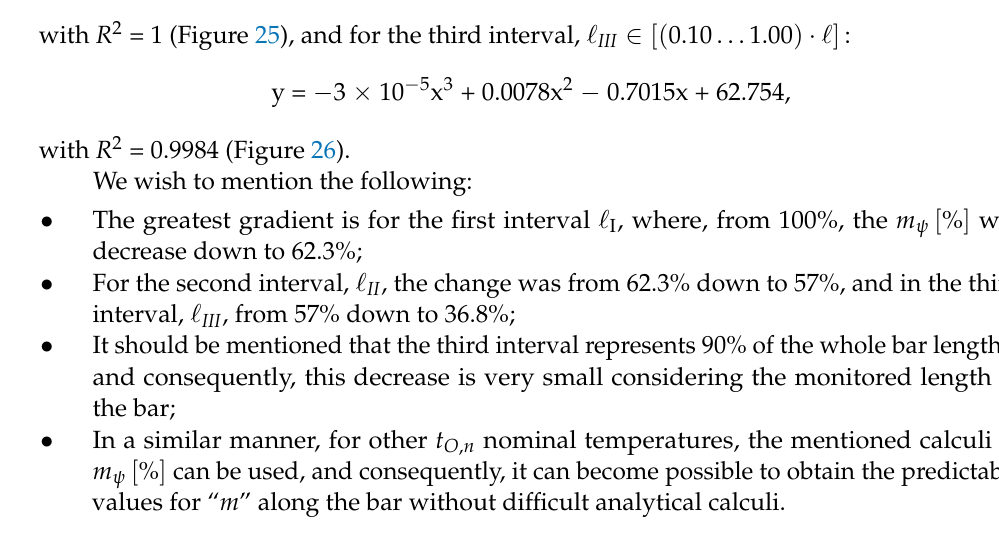
Figure 25. The relative m ψ [ % ] vs. (cid:96) [ % ] along the second interval, (cid:96) II ∈ [( 0.05 . . . .0.10 ) · (cid:96) ] .